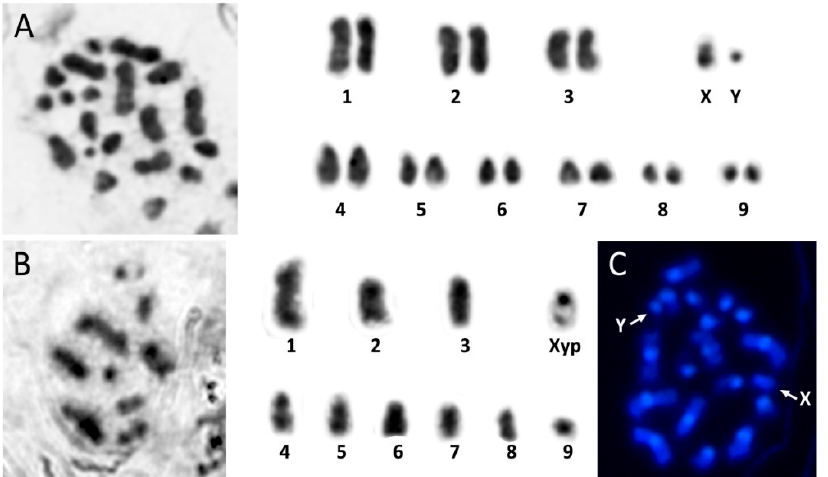
Figure 1. Mitotic ( A ) and meiotic ( B ) karyotype of Hippodamia variegata . ( C ) Mitotic metaphase stained with DAPI after C-banding showing pericentromeric heterochromatin in all chromosomes, including X and Y chromosomes.